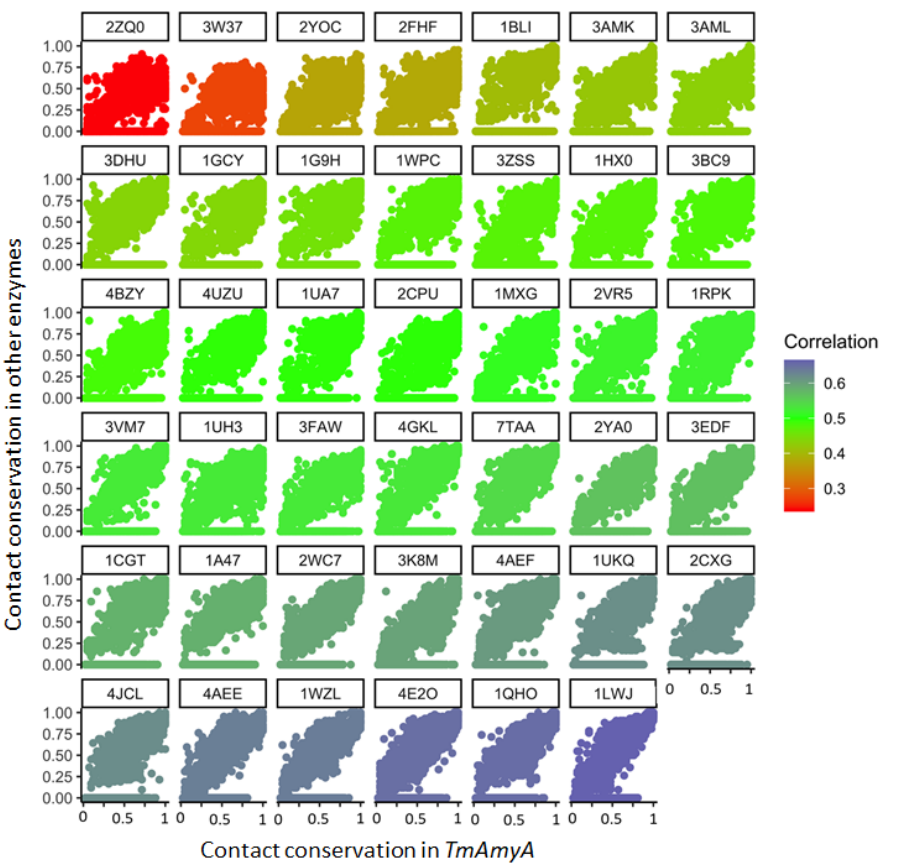
Figure 2. Correlation of the residue-residue contact conservation between all enzymes and those of TmAmya, one of the enzymes modified in this study. The preservation of each contact in a protein is plotted against its conservation in TmAmyA. This parameter seems to correlate with phylogenetic relationships. A poor correlation is evident for the enzymes not belonging to the GH13 family (e.g., PDB ID: 2ZQ0, family GH97, and enzyme with the PDB ID: 3W37, family GH31).